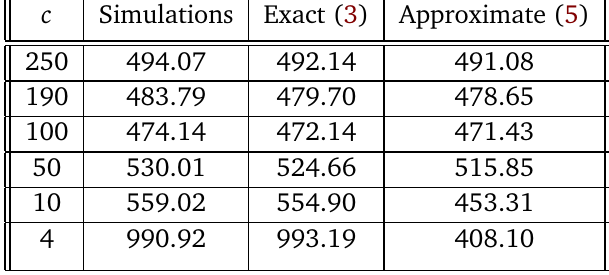
Table 2: Comparison between simulations, exact, and approximate value for the MFPT on weighted random regular networks of different connectivity c